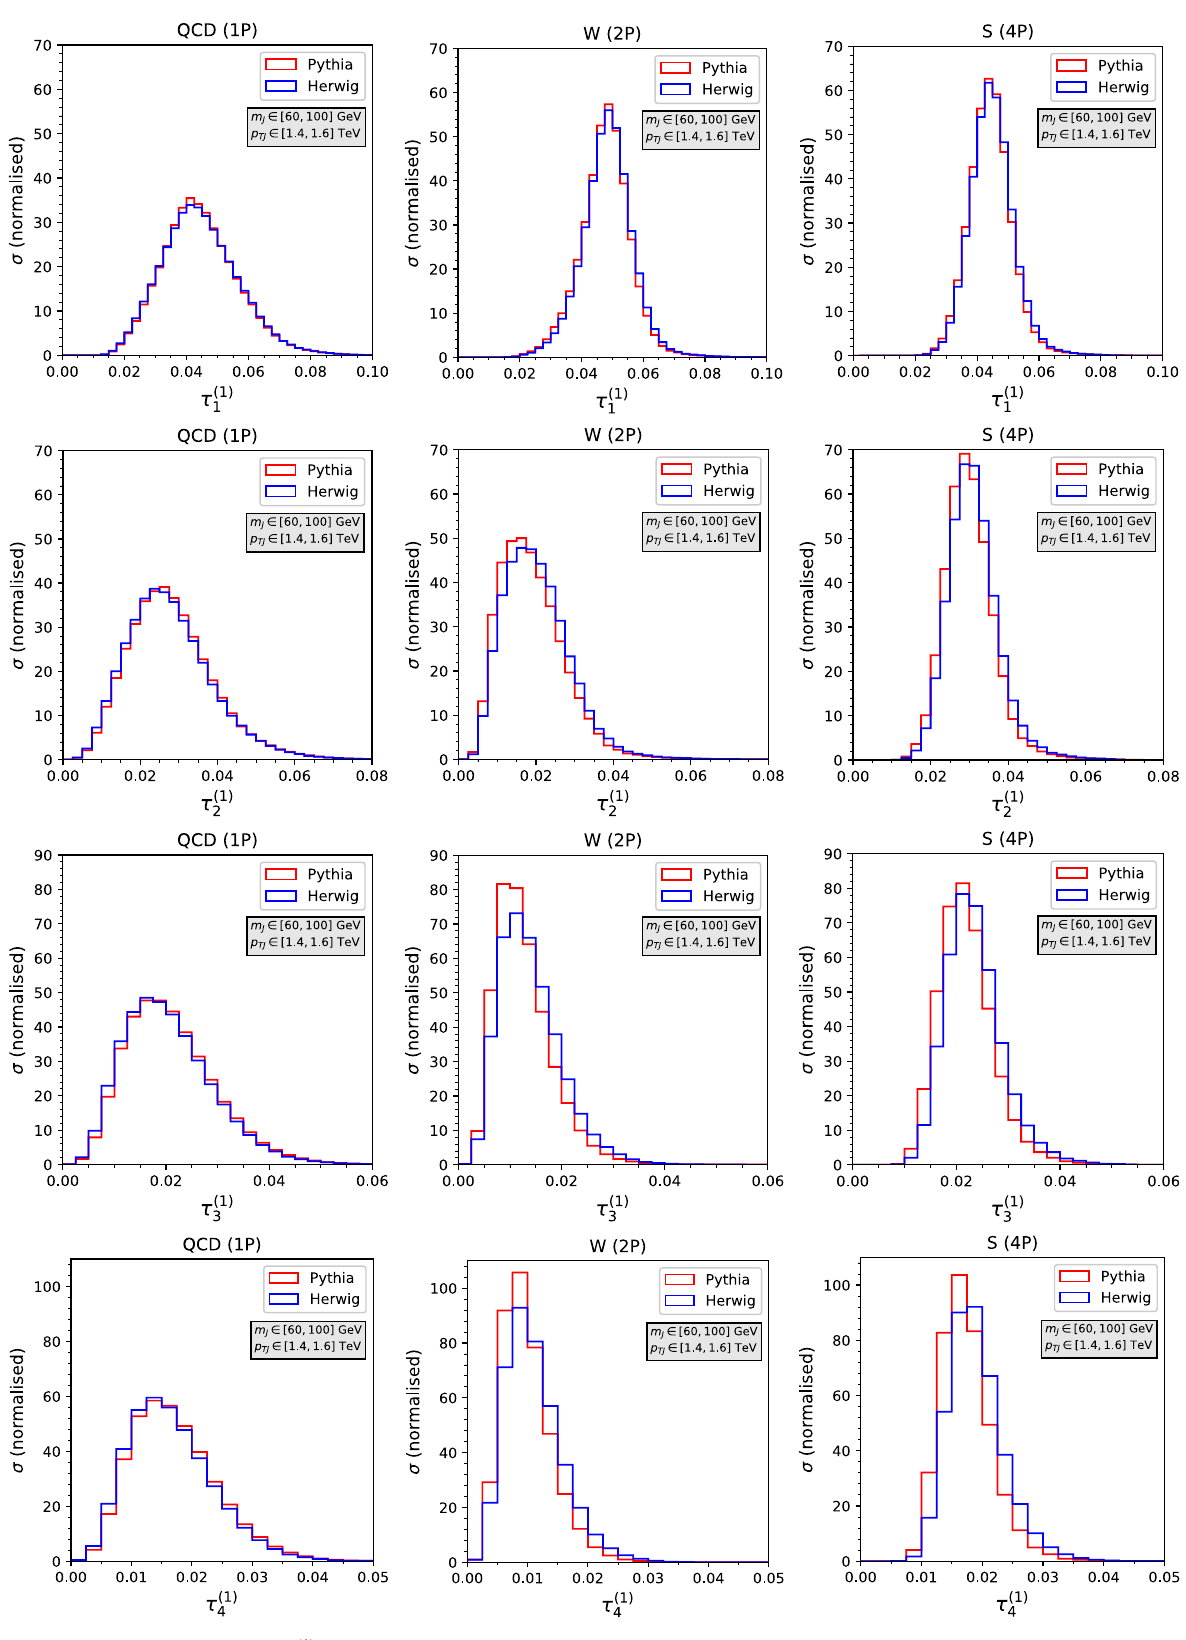
Fig. 1 Normalised distributions of τ ( 1 ) n with n = 1 , 2 , 3 , 4, for QCD and multi-pronged jets with m J ∈ [ 60 , 100 ] GeV (see the text for